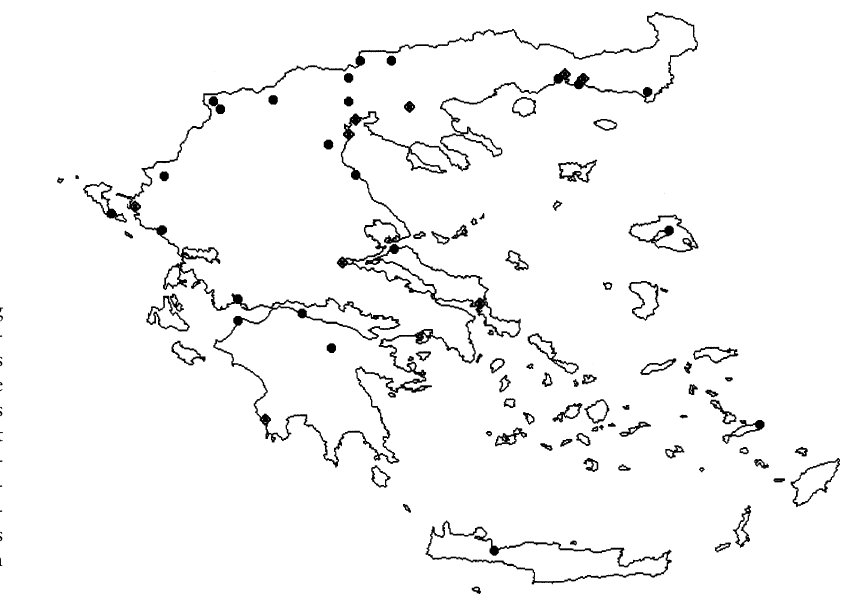
Fig. 2. All wetland sites appearing in any one of the alternative 26- site optimal solutions. In all cases (regardless the criterion set) the minimum number of reserves containing all species at least once were 26 sites. A circle indi- cates each one of the 23 mono- specific sites included in any so- lution, while a diamond indicates the rest alternate sites by which the additional three are